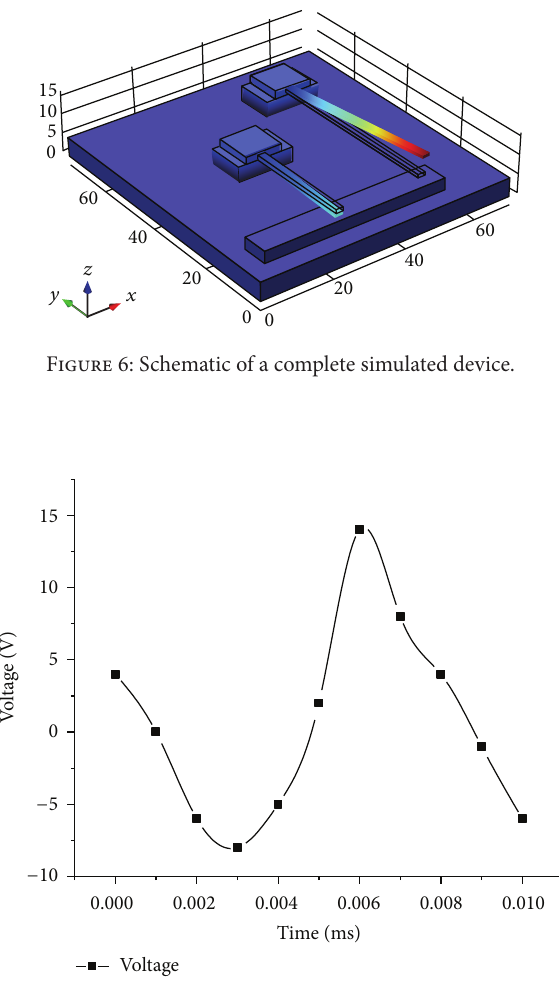
Figure 7: Resultant output waveform showing low frequency signal.